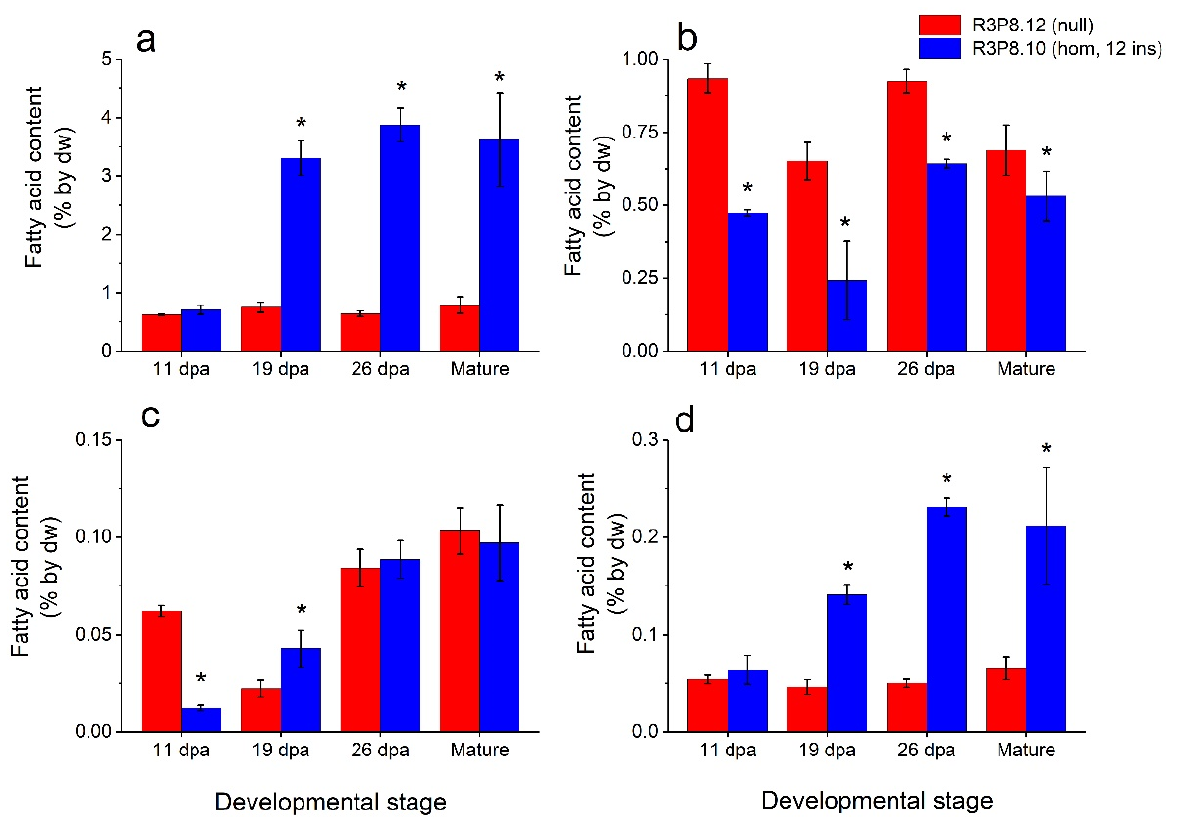
Figure 3. Lipid content based on amounts of the major fatty acids 16:0 (palmitic acid), 18:0 (stearic acid), 18:1 (oleic acid), 18:2 (linoleic acid), and 18:3 (linolenic acid) in the endosperms of developing caryopses from field grown AsWRI1 -wheat (line R3P8.12, null (control); line R3P8.10, homozygous with 12 gene inserts). Levels of fatty acids are given as percentage of tissue dry weight (dw) of ( a ) triacylglycerol (TAG), ( b ) polar lipids (PL), ( c ) free fatty acids (FFA), and ( d ) other lipids at 11-, 19-, and 26-days post anthesis (dpa) and at seed maturity. Results are mean values of three replicates (i.e., plots) ± standard deviation. Bars marked with asterisks are significantly different to control (null) according to Fisher’s pairwise comparisons ( p < 0.05).